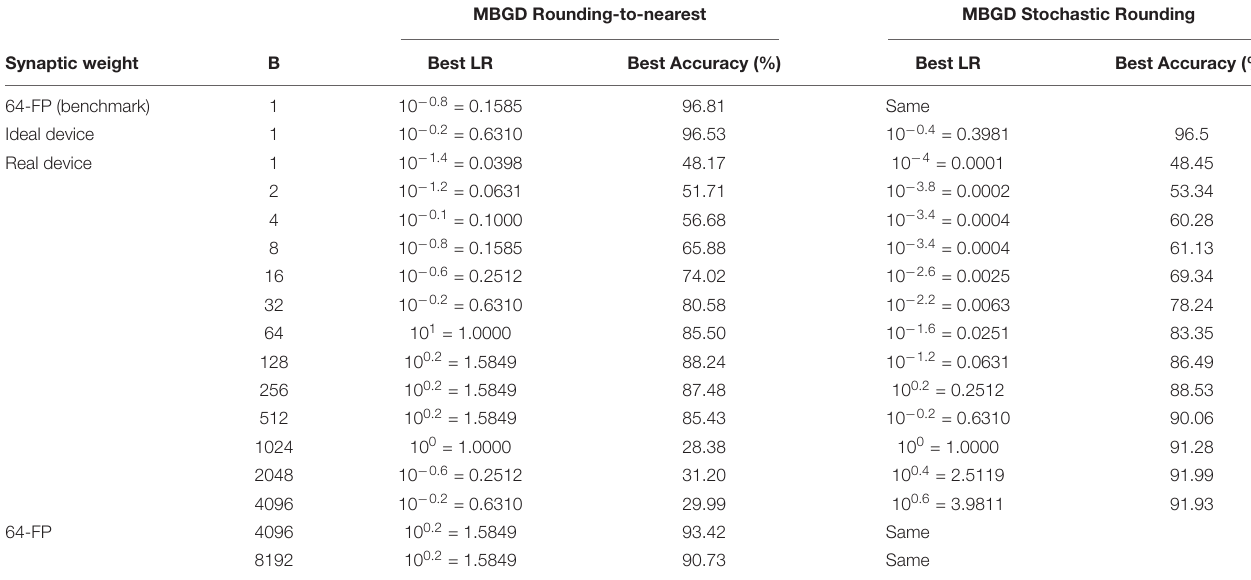
FIGURE 5 | The MBGD results for rounding to nearest and stochastic rounding. Learning rate windows for ideal and non-ideal device models and batch sizes using (A) rounding-to-nearest vs. (B) stochastic rounding of the delta weight. Best convergence curves for the optimal learning rate for each batch size using (C) rounding-to-nearest vs. (D) stochastic rounding. (E) Optimal learning rate corresponding to the highest accuracy vs. the batch size for non-ideal devices. It is observed that the learning rate increases supra-linearly with the batch size. (F) Best accuracy at the optimal learning rate vs. the batch size. In (E) and (F) , the colorful plot markers represent results at convergence. The faded gray markers for the rounding-to-nearest case represent the inability of the network to train properly due to vanishing gradients in this low precision model. The values for the batch sizes 1 to 4096 are obtained using the realistic memristor model. Representative results for software and ideal device model are also included for comparison. TABLE 1 | Best accuracy observed between the rounding methods at different batch sizes. MBGD Rounding-to-nearest MBGD Stochastic